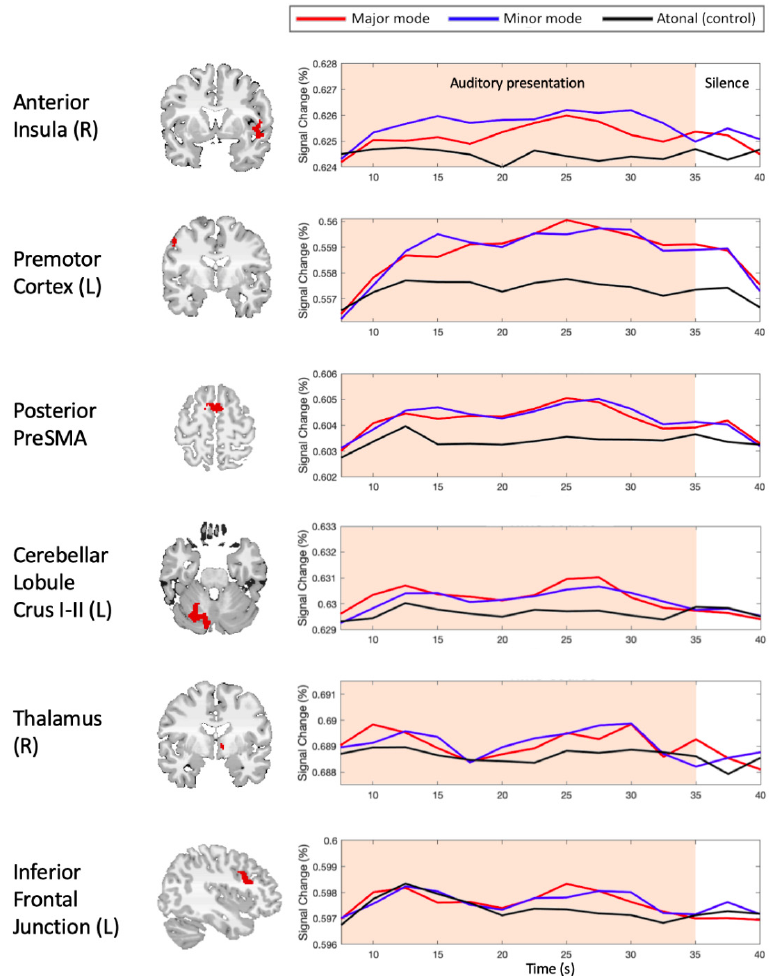
Figure 4. Time courses of focal brain activity in a subset of activated locations. Left panels: activation clusters. Right panels: averaged time courses of blood-oxygen-level dependent (BOLD) signal change.